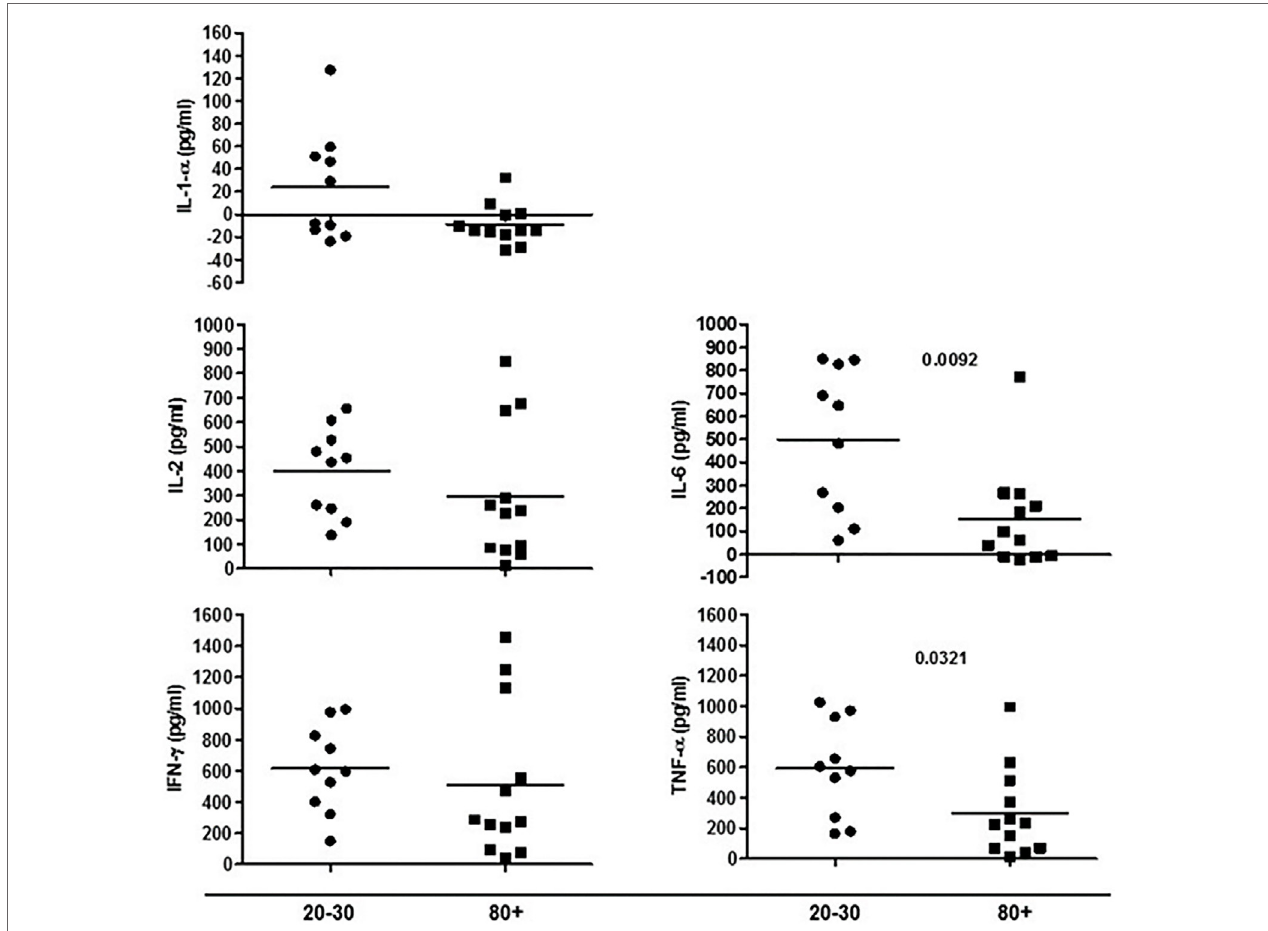
FigUre 6 | Cytokines produced by cells in culture under phytohemagglutinin stimulus according to age: 20–30 and 80 + years old.